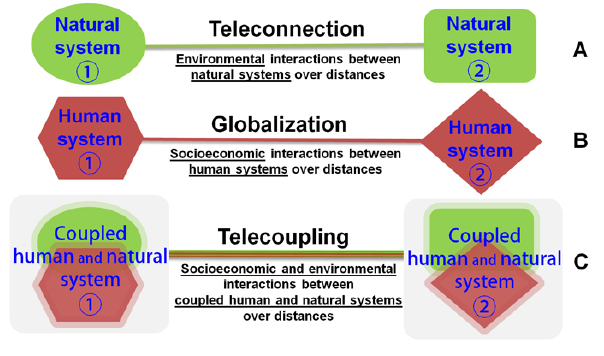
Fig. 1 . Definitions of teleconnections, globalization, and